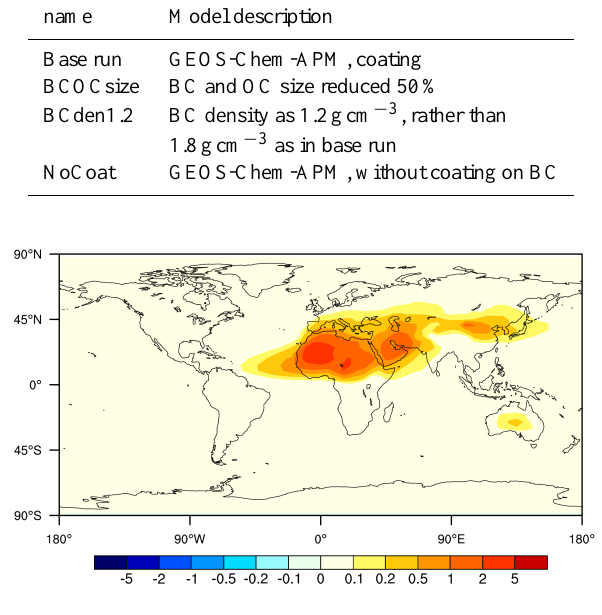
Fig. 6. Longwave radiative forcing at TOA induced by mineral dust. Unit: Wm − 2 .